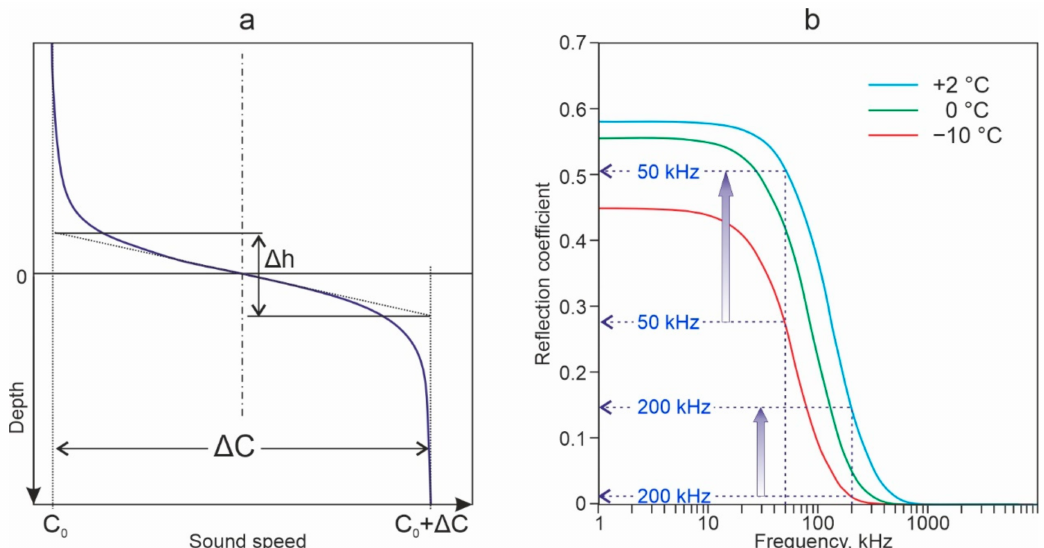
Figure 8. ( a ) Boundary between two homogeneous layers as an Epstein transition layer with a thickness ∆ h ; ( b ): frequency dependence of reflection from the sand–clay interface as an Epstein transition layer with = 10 mm at temperatures +2 ◦ C (1), 0 ◦ C (2), and − 10 ◦ C (3). Violet arrows show a reflection coefficient increase from +2 ◦ C to − 10 ◦ C cooling of the 10 mm thick